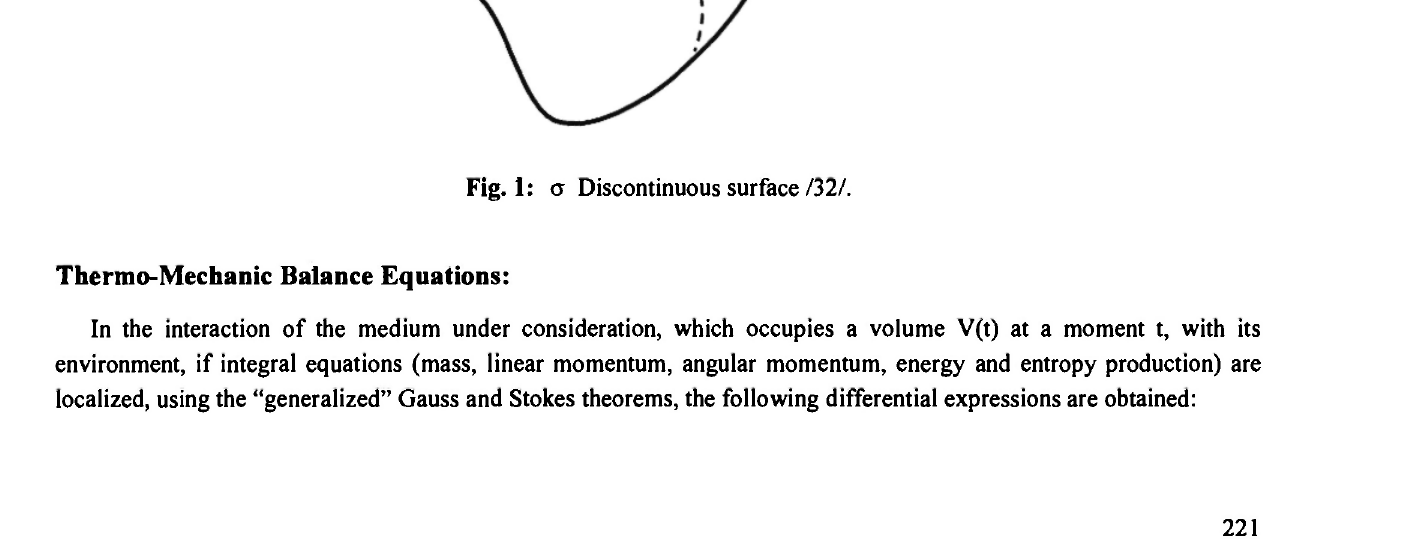
Fig.l: σ Discontinuous surface/3